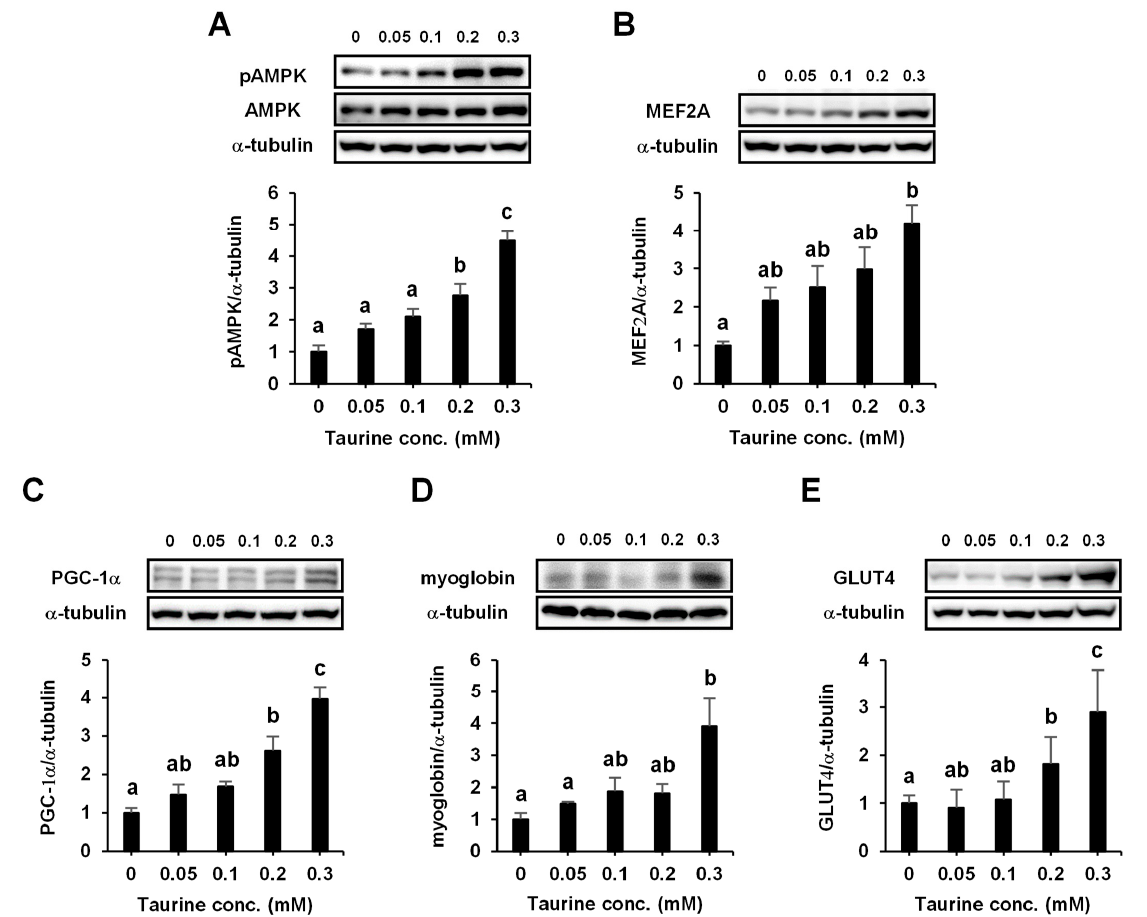
Figure 6. Taurine stimulates the phosphorylation of AMPK ( A ) and the expression of MEF2A ( B ), PGC-1 α ( C ), myoglobin ( D ), and GLUT4 ( E ) proteins in L6 myotubes. L6 myotubes were treated with 0, 0.05, 0.1, 0.2, and 0.3 mM taurine for 1 h. After treatment, L6 cells were analyzed by Western blot, as described in Materials and Methods section. Values shown represent the mean ± SE (n = 3–6). Results were analyzed using one-way ANOVA followed by Tukey’s test for multiple comparisons. Values with different superscript lowercase letters indicate significant differences ( p < 0.05).